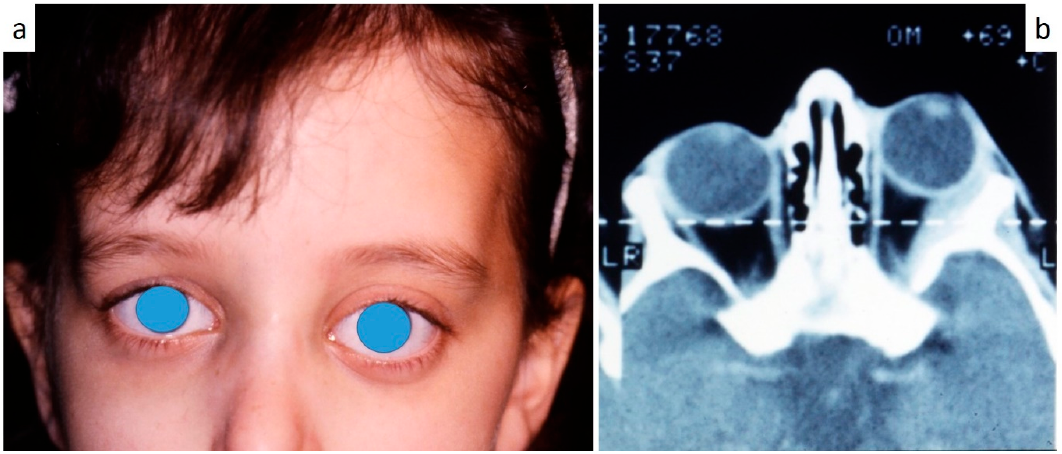
Figure 7. ( a , b ): Exophthalmia ( a ) in LCH patient as confirmed by CT scan ( b ).